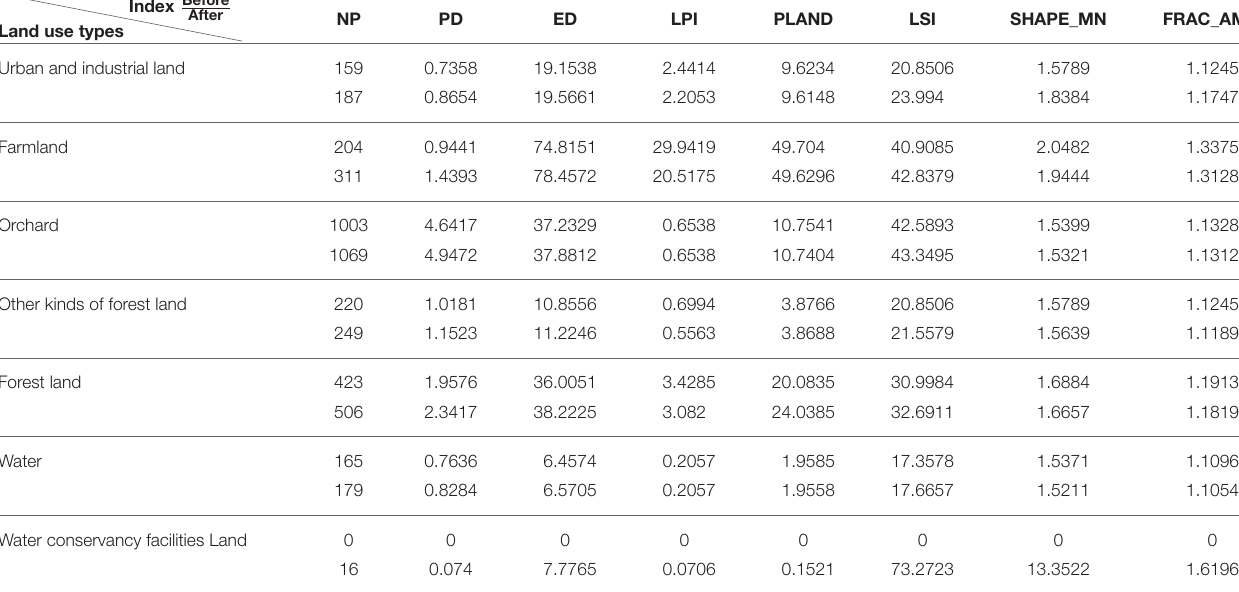
TABLE 6 | Statistics of pattern metrics in class